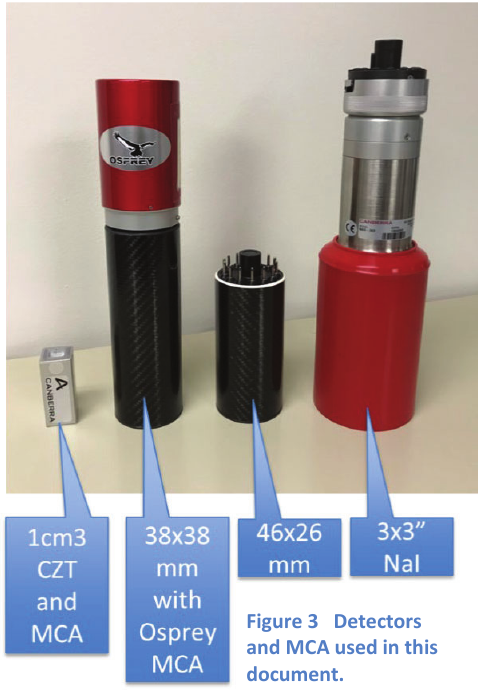
Figure 3 Detectors and MCA used in this